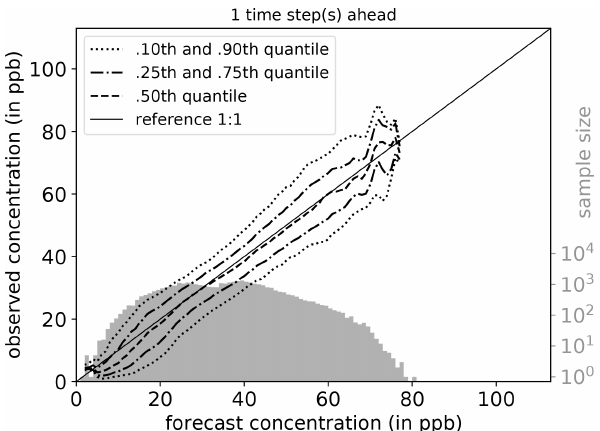
Figure 10. Conditional quantiles in terms of calibration-refinement factorization for the first lead time and the full test period. The marginal forecasting distribution is shown as a log histogram in light grey (counting on right axis). The conditional distribution (cal- ibration) is shown as percentiles in different line styles. Calcula- tions are done with a bin size of 1ppb. Moreover, the percentiles are smoothed by a rolling mean of window size three. This kind of plot was originally proposed by Murphy et al. (1989) and can be created using PlotConditionalQuantiles .